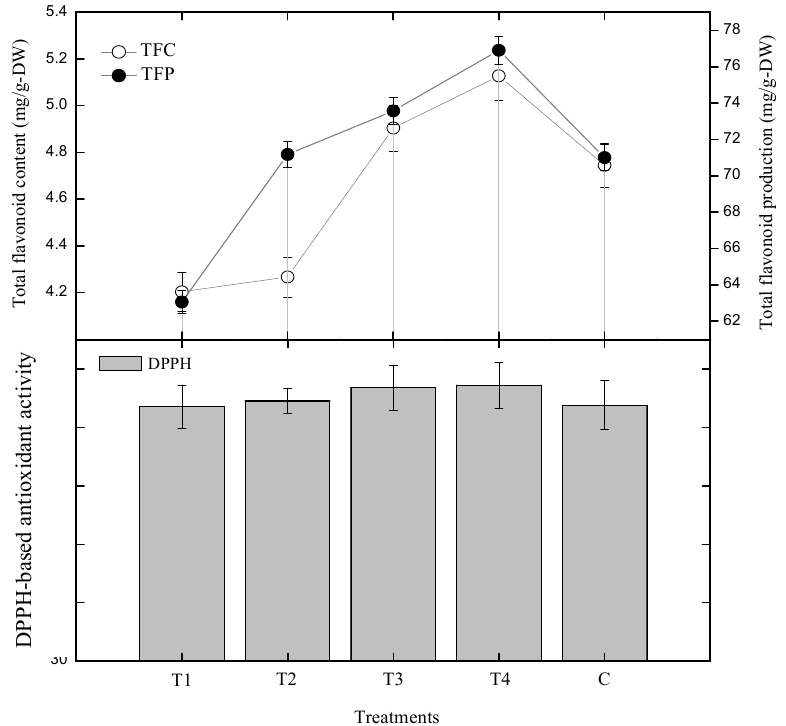
Figure 4. Correlation between DPPH-based antioxidant activity and phenolics in S. rebaudiana adventitious root cultures in vitro. The triplicate data in the mean along with standard errors (SE) are significantly different at p < 0.05.